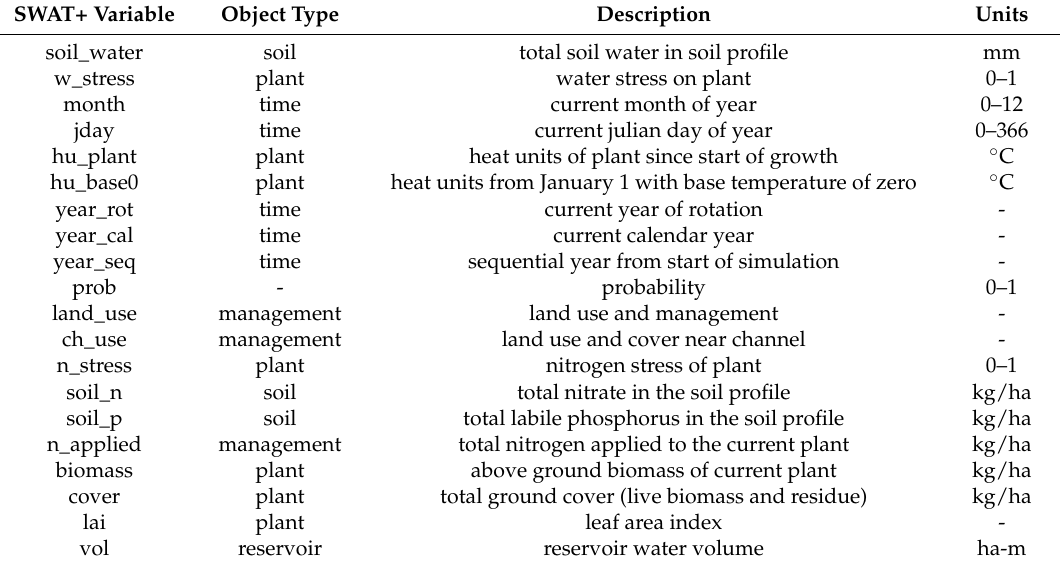
Table 2. Conditional variables currently coded in the Soil and Water Assessment Tool (SWAT+) for use in the decision tables.